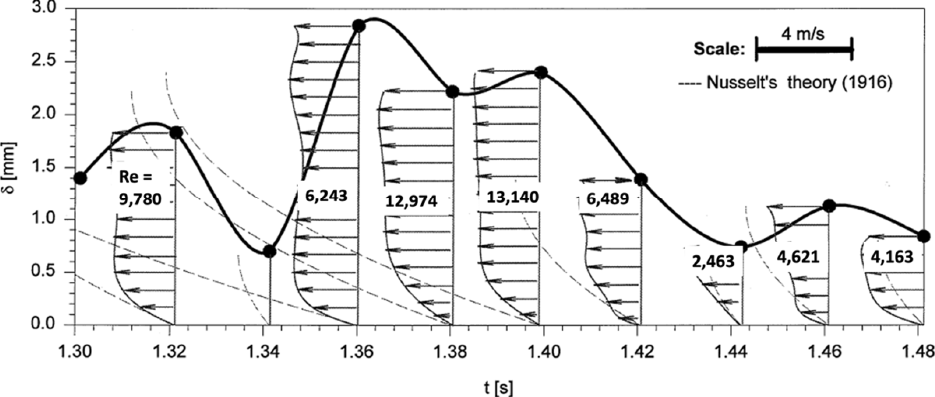
Figure 14. Velocity and thickness profiles of a falling film at a liquid Reynolds number of 5275, adapted with permission from [63], 1998, Elsevier.